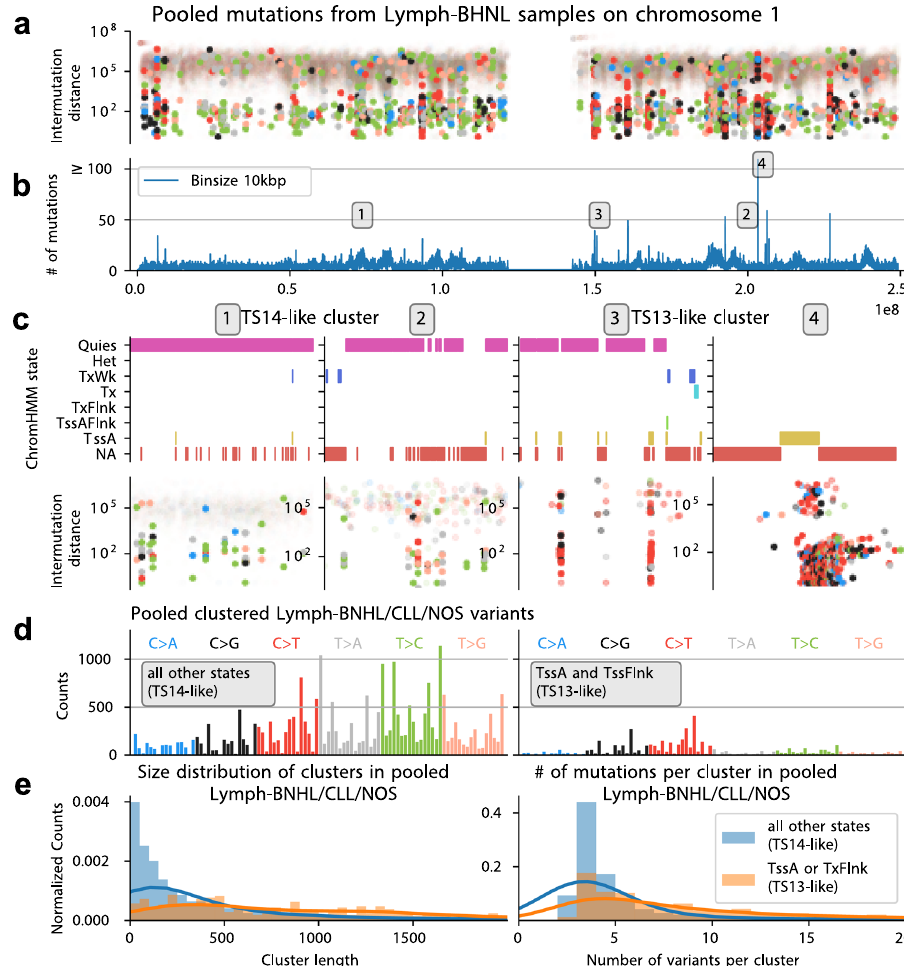
Fig. 7 Identi fi cation of a highly clustered mutational signature at active TSS. a Rainfall plot of pooled variants from Lymph-BHNL samples on chromosome 1 (highlighted dots indicate clustered mutations). b Binned (10 kb) SNV counts of chromosome 1. Numbers 1-4 indicate mutation hotspots. c Consensus ChromHMM states and rainfall plots at mutation hotspots. d Pooled clustered variants from PCAWG Lymph-BHNL/CLL/NOS samples from TssA or TxFlnk (TS13-like), and all other epigenetic states (TS14-like). e Size distribution of mutation clusters (consecutive clustered mutations), and the distribution of number of variants per mutation cluster in TS13 and TS14 high samples respectively. Source data are provided as a Source Data fi